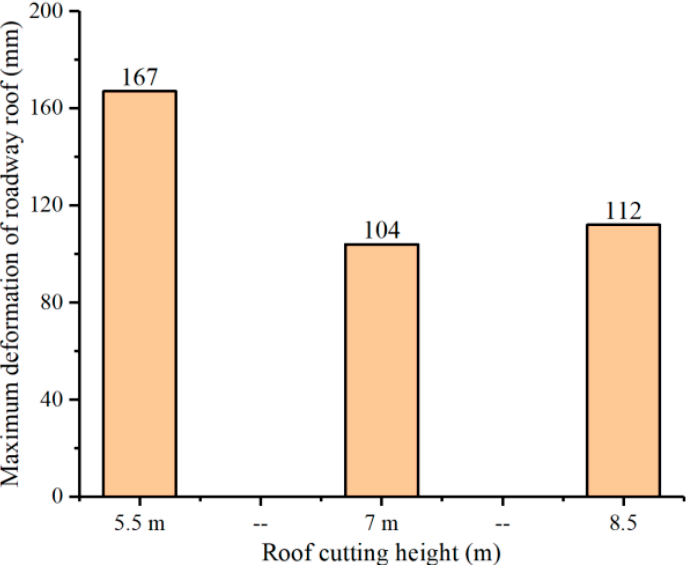
Figure 7. Maximum deformation of the roadway roof for different cutting heights.